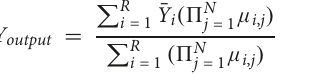
is visible and that all landmarks are independent of each